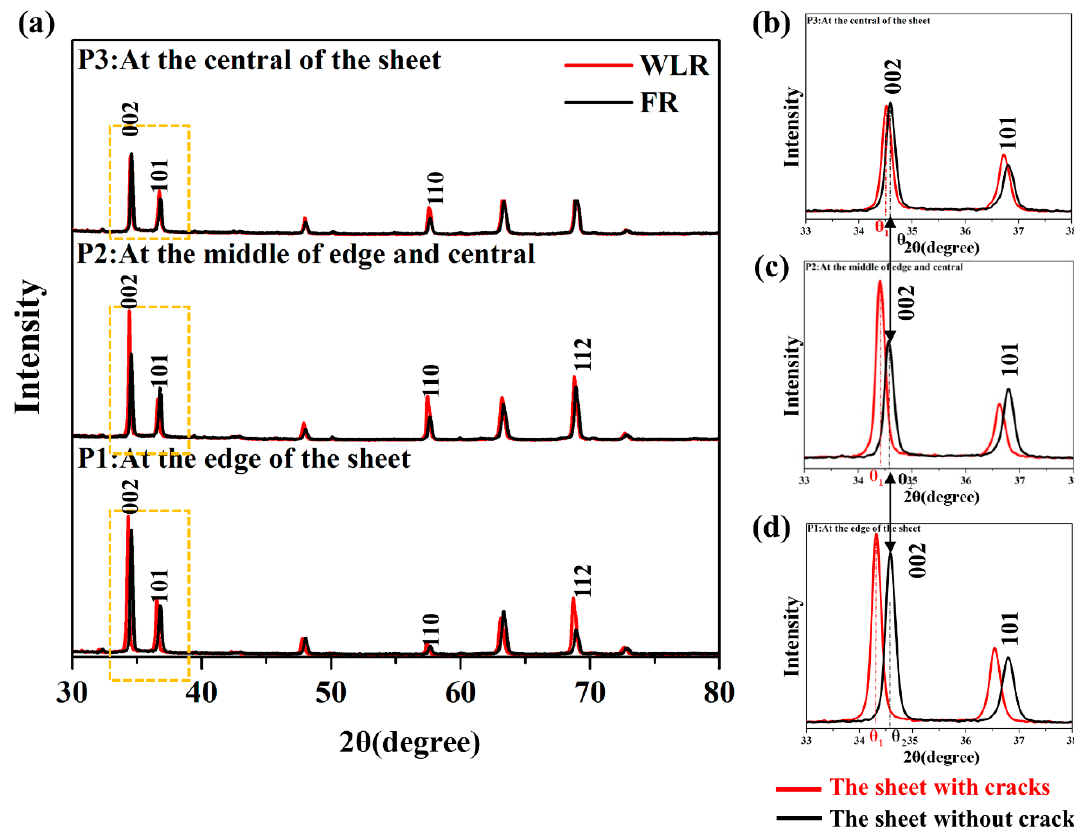
Figure 5. XRD spectra of the sheets without cracks and with cracks. ( a ) XRD spectra of the samples cut from P1, P2, and P3 on the sheets. ( b – d ) XRD spectra showing the marked yellow dotted line in Figure 5a.